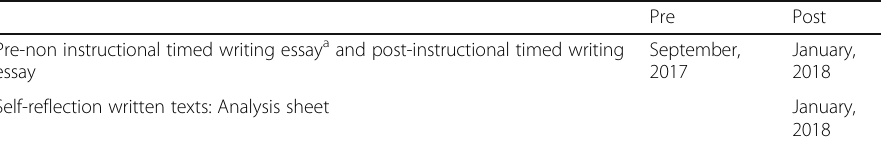
Table 4 Data Collection Dates